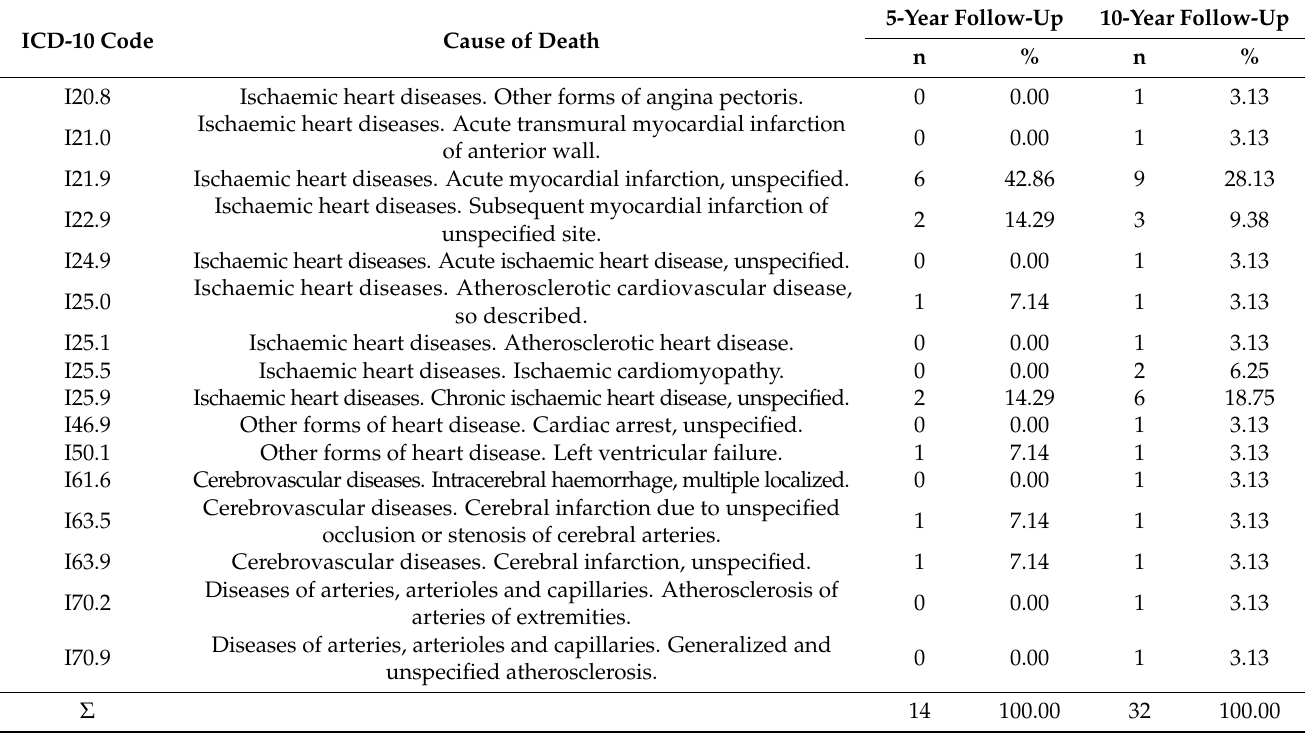
Table 2. Cardiovascular causes of death in 5-year and 10-year follow-up.